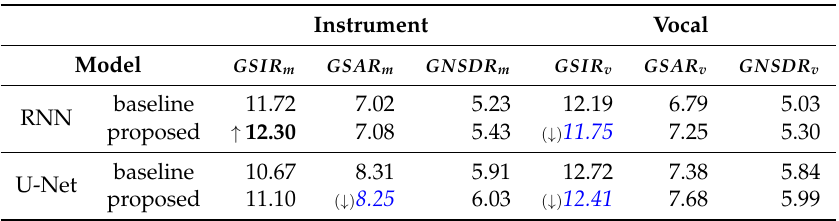
Table 2. Comparison of separation performance for MIR-1K dataset by global normalized source to distortion ratio (GNSDR), global source to artifact ratio (GSAR) and global source to interference ratio (GSIR). “Instrument” columns with subscript “ m ” are the evaluation results of instrument sound extraction, and “Vocal” columns with subscript “ v ” are those of vocal sound extraction. The baseline models are stacked RNN (“RNN” row) and U-Net (“U-Net” row). The rows with “proposed” header are the models trained by the proposed curriculum learning method.